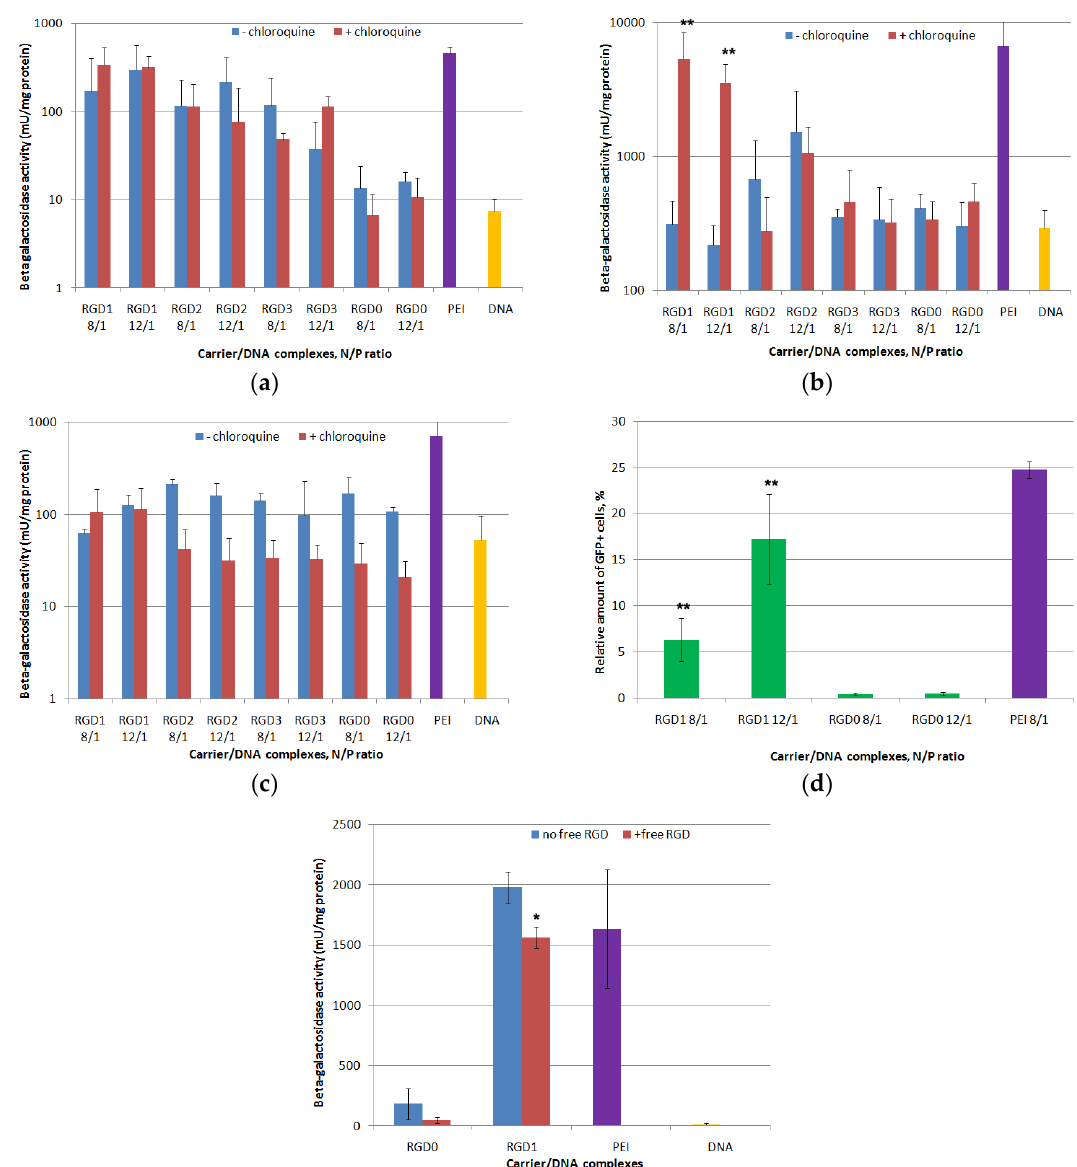
Figure 8. DNA transfection efficacy evaluation. The PANC-1 ( a ), HeLa ( b ) and 293T ( c ) cell lines were transfected with RGD1/DNA, RGD2/DNA, RGD3/DNA and RGD0/DNA polyplexes at charge ratios of 8/1 and 12/1, pCMV-lacZ plasmid alone and PEI/DNA. The transfection experiments were performed in the absence or presence of chloroquine. The PANC-1 cell line ( d ) was transfected with complexes of pEXPR-IBA5-eGFP plasmid and RGD1 and RGD0 carriers with charge ratios of 8/1 and 12/1. PEI polyplexes at an 8/1 charge ratio wereapplied as the control. Competitive transfection ( e ): the PANC-1 cells were transfected with RGD1/DNA and RGD0/DNA complexes at charge ratios of 8/1, pCMVlacZ plasmid alone and PEI/DNA. A free cyclo(RGDfK) ligand was added to the cells to compete with the complexes for binding of αvβ3 integrins. Reporter lacZ gene expression is given as milliunits (mU) per milligram of protein. GFP gene expression is given as a percentage of GFP-positive cells according to cytometry data. Values are the mean ± SD of the mean of triplicate experiments. * p < 0.05, ** p < 0.01 compared to RGD0/DNA complexes or compared to untreated complexes.